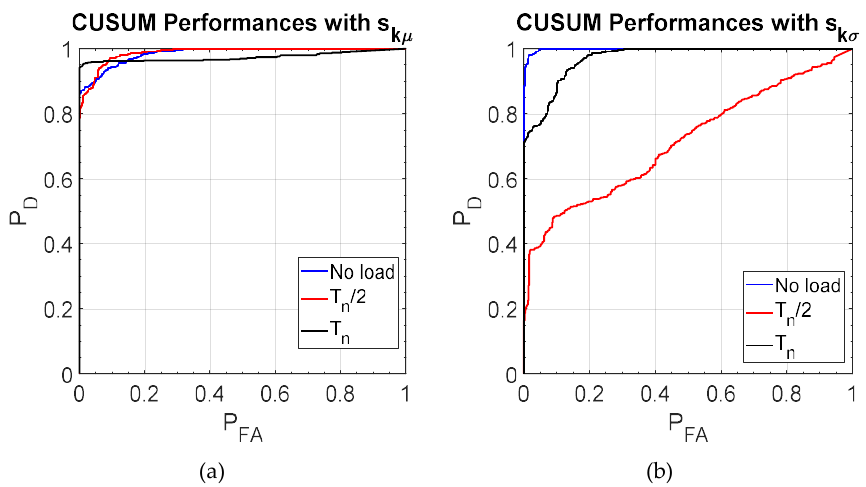
Figure 15. 100 µ s OSF detection performance for SNR = 20 dB at 20 rad / s: ( a ) With the mean value, Figure 15. 100 µs OSF detection performance for SNR = 20 dB at 20 rad/s: ( a ) With the mean value, ( b ) ( b ) With the variance. With the variance.